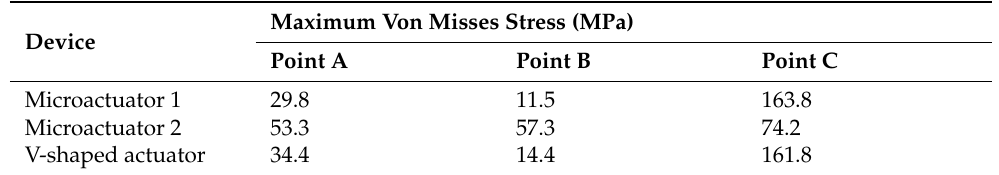
Table 8. Equivalent von Mises voltage results for the considered microactuators.